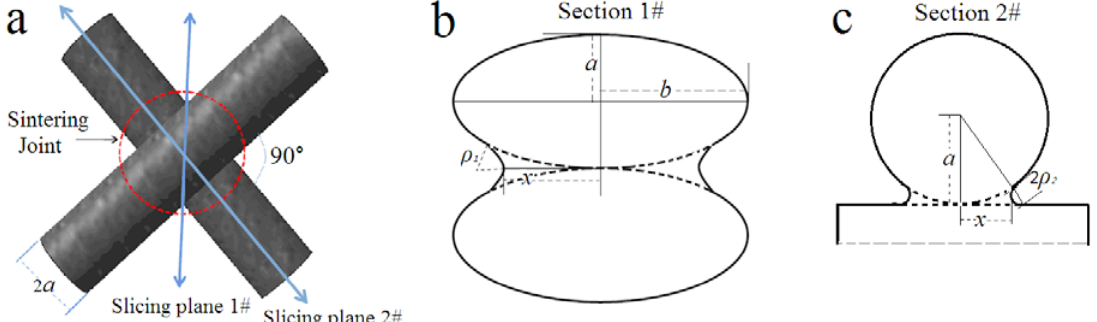
Figure A1. The sections of a sintering joint of 90° cut in different directions, ( a ) Directions of the two slicing planes, ( b ) Section 1# cut by slicing plane 1#, ( c ) Section 2# cut by slicing plane 2#.